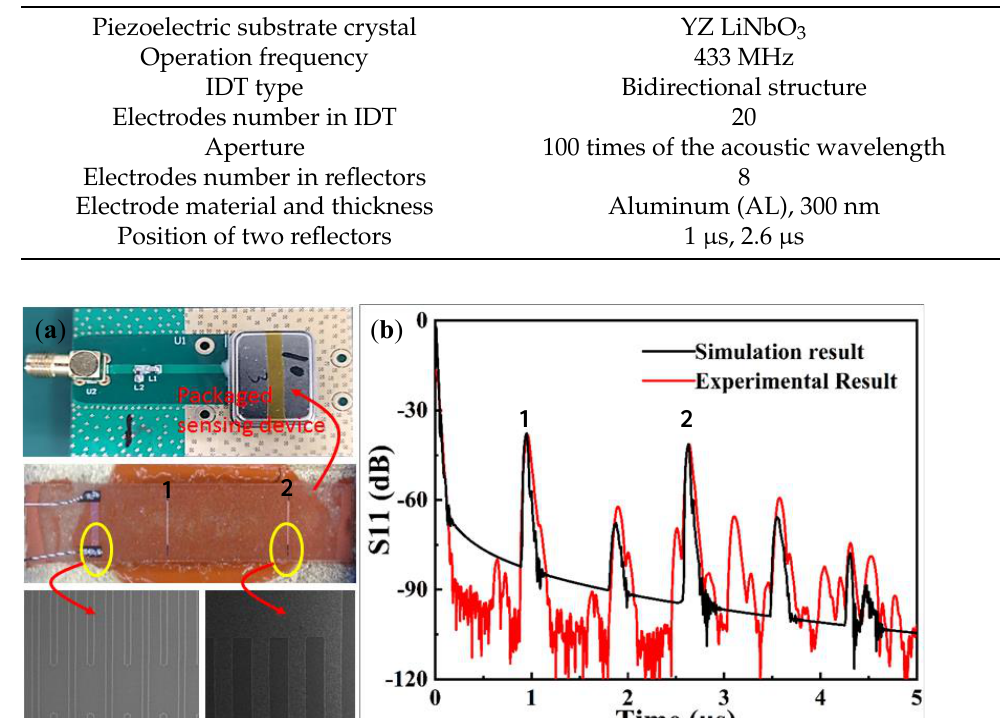
Table 1. SAW temperature sensor design parameters.